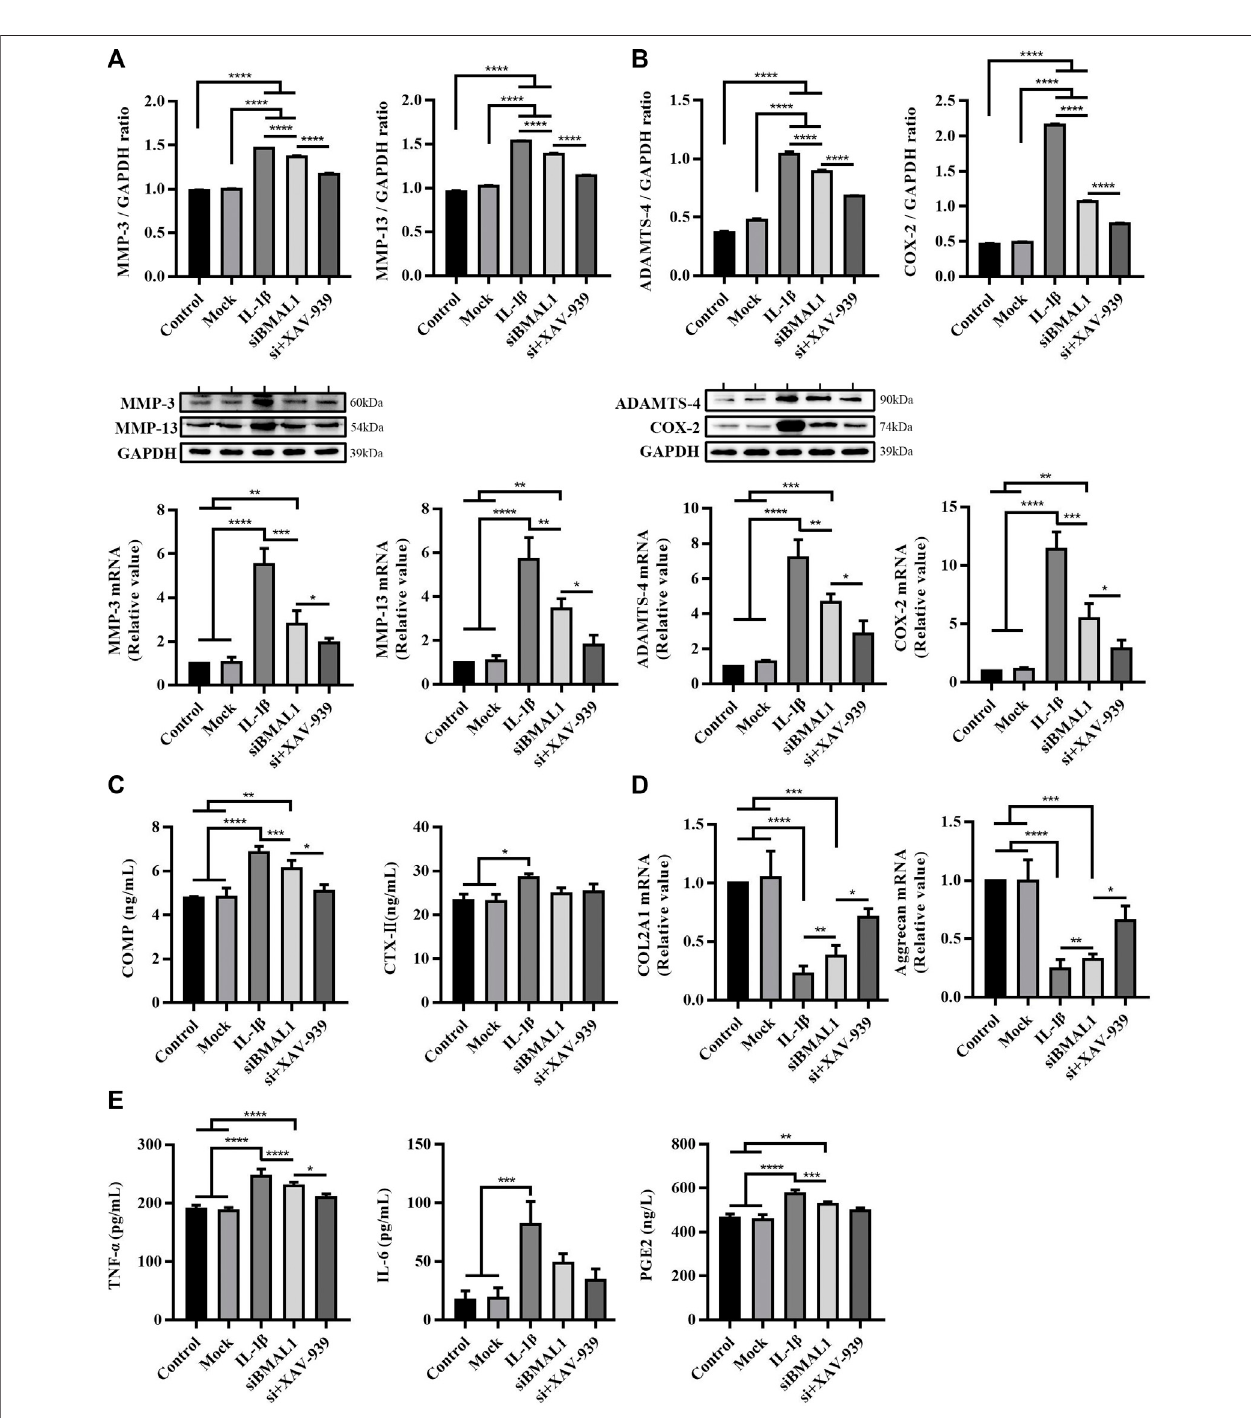
FIGURE 4 | Cartilage matrix degradation and in fl ammation response in chondrocytes after stimulating with IL-1 β , transfecting with siBMAL1 and suppressing β -catenin pathway. (A) Protein expression and mRNA level changes of MMP-3 and MMP-13 in chondrocytes in each group. (B) Protein expression and mRNA levels changes of ADAMTS-4 and COX-2 in chondrocytes in each group. (C) Levels of COMP and CTX- Ⅱ in ECS. (D) mRNA level changes of COL2A1 and Aggrecan in chondrocytes in different groups. (E) Levels of TNF- α , IL-6, and PGE2 in ECS. All experiments were performed in triplicate, and the results are expressed as the mean ± SEM. * p < 0.05, ** p < 0.01, *** p < 0.001, and **** p < 0.0001.